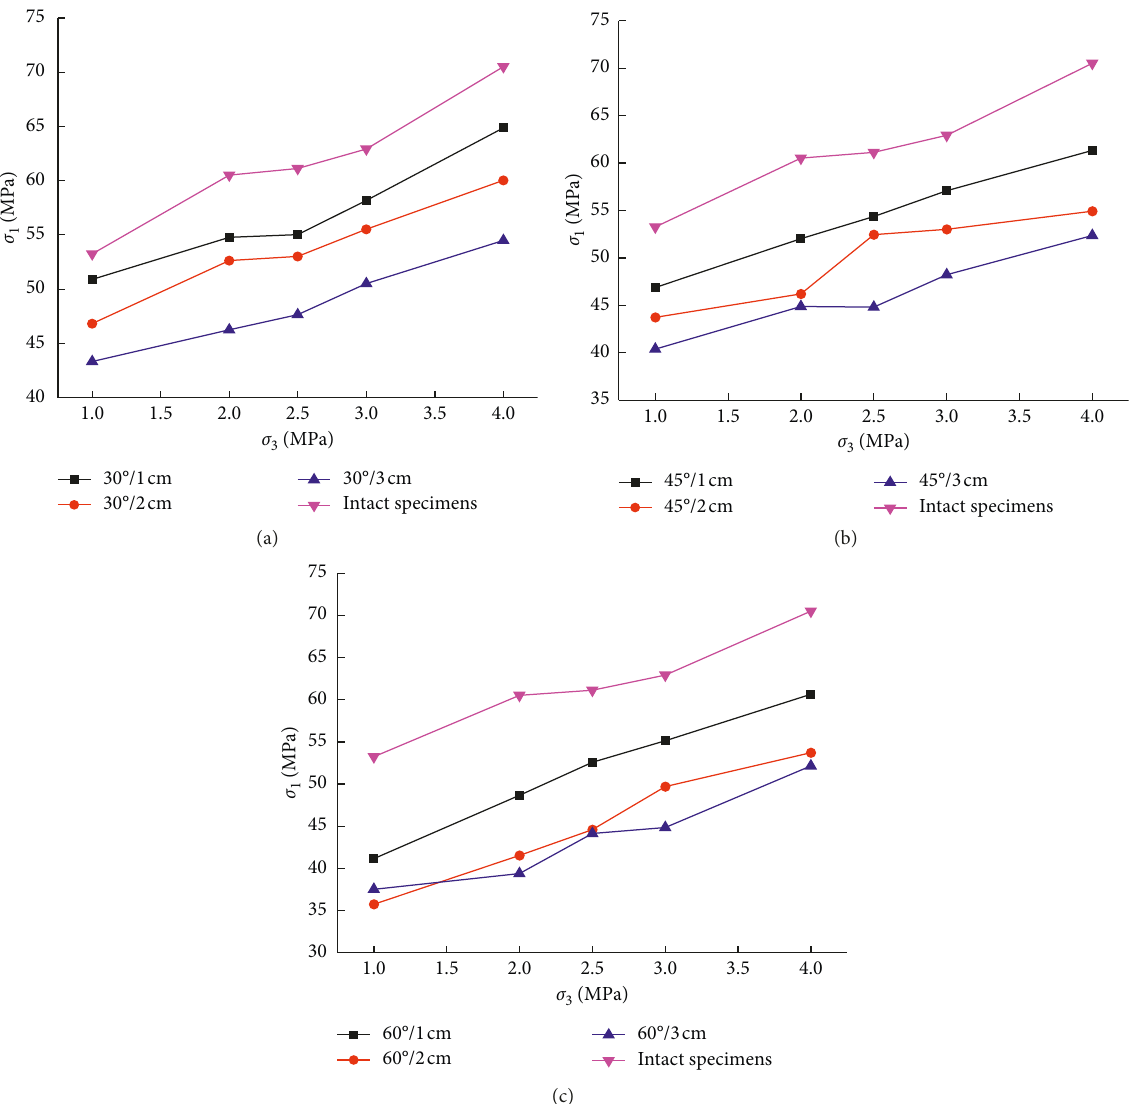
Figure 8: Variation in the peak strength of the grouted and intact samples with changes in the confining pressure with flaw inclination angles of (a) 30 ° , (b) 45 ° , and (c) 60 °